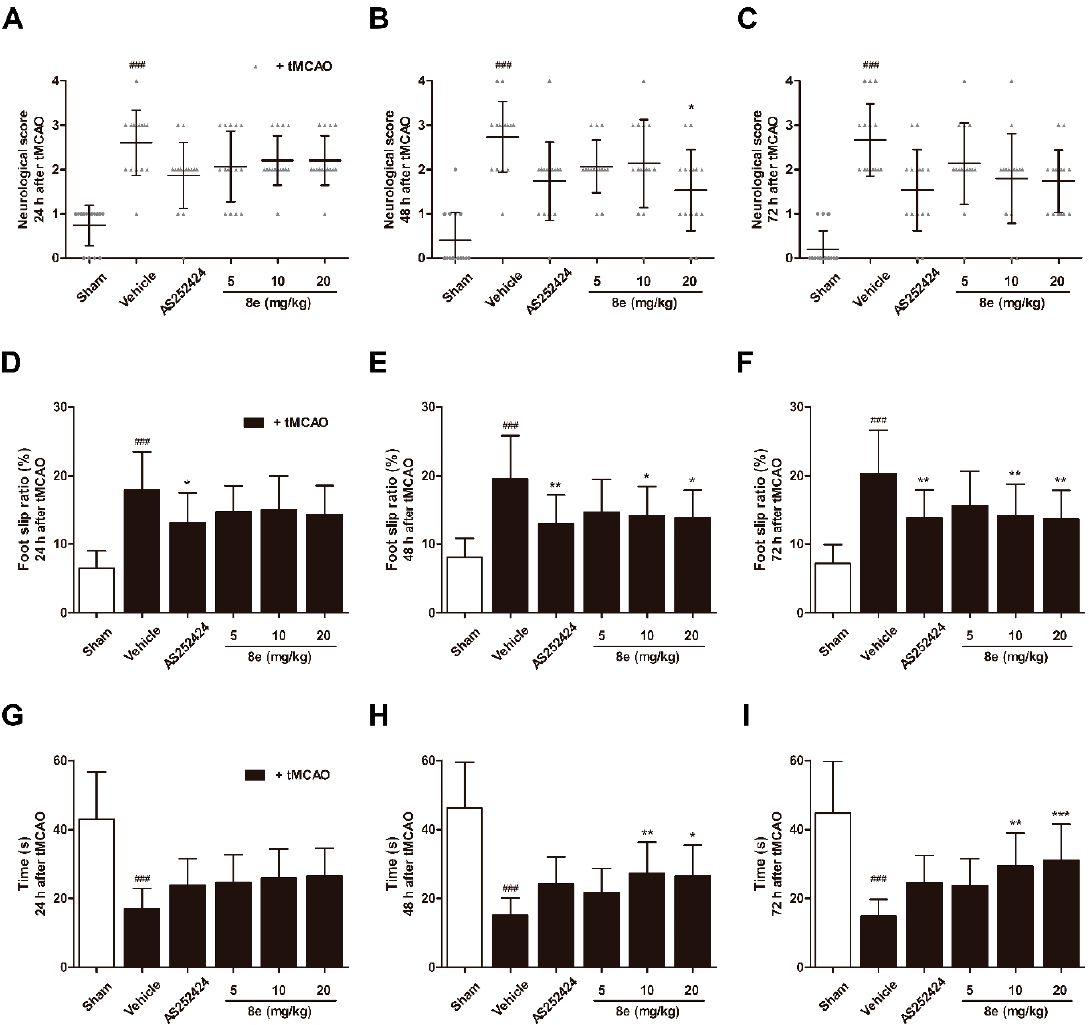
Figure 2. 8e enhanced sensorimotor function after cerebral ischemia/reperfusion (I/R) in rats. ( A – C ) Neurological scores in Longa test; ( D – F ) foot slip ratios in beam walking test; ( G – I ) time spent on the rope in prehensile traction test at 24 h, 48 h and 72 h after transient middle cerebral artery occlusion (tMCAO). Data are presented as mean ± SD ( n = 15). ### p < 0.001 vs. sham group. * p < 0.05, ** p < 0.01, *** p < 0.001 vs. tMCAO + vehicle group.